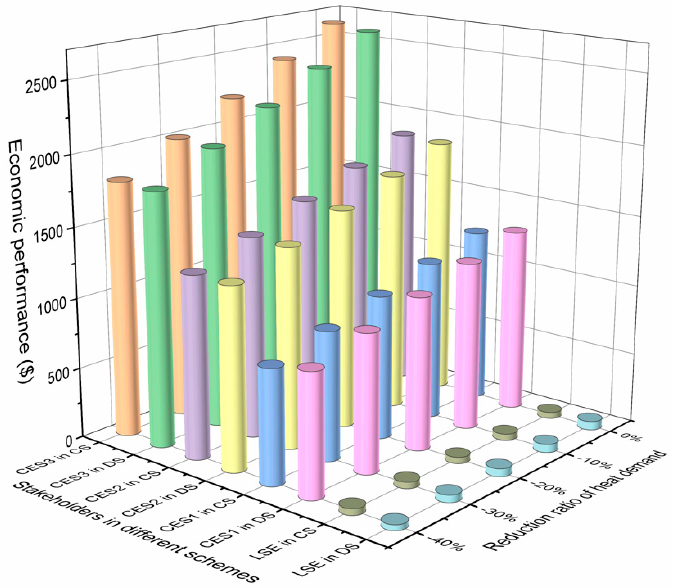
Figure 8. E ff ect of energy demand on the economic benefit of stakeholders (CS: centralized coordination Figure 8. Effect of energy demand on the economic benefit of stakeholders (CS: centralized scheme; DS: decentralized coordination coordination scheme; DS: decentralized coordination scheme).